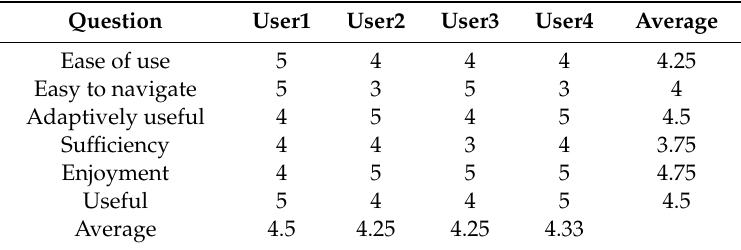
Table 9. Surveys of